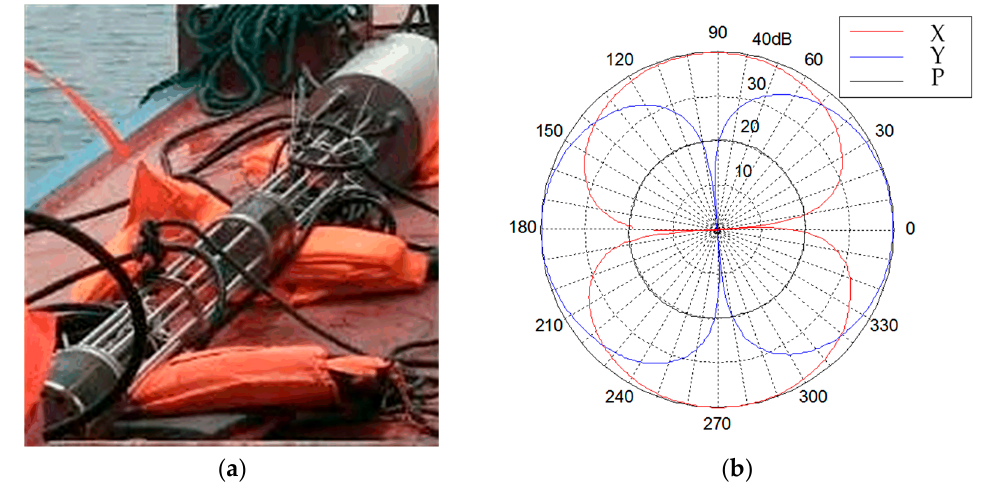
Figure 9. ( a ) The AVS and electronic equipment cabin used in the experiments; ( b ) The AVS directivity patterns ( @ 630 Hz).